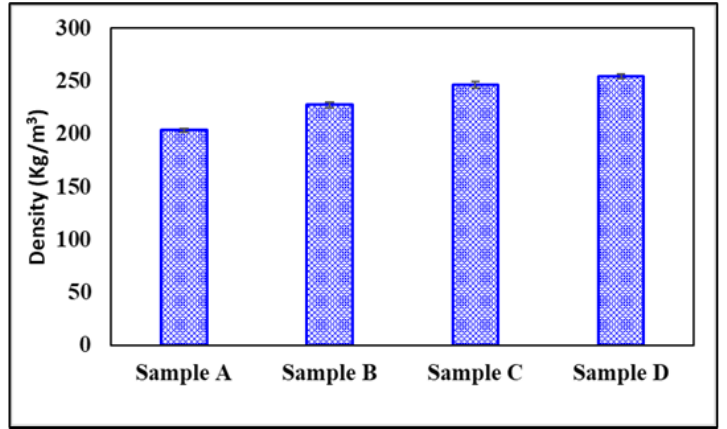
Figure 4. Density of four insulation composites based on three triplicates.